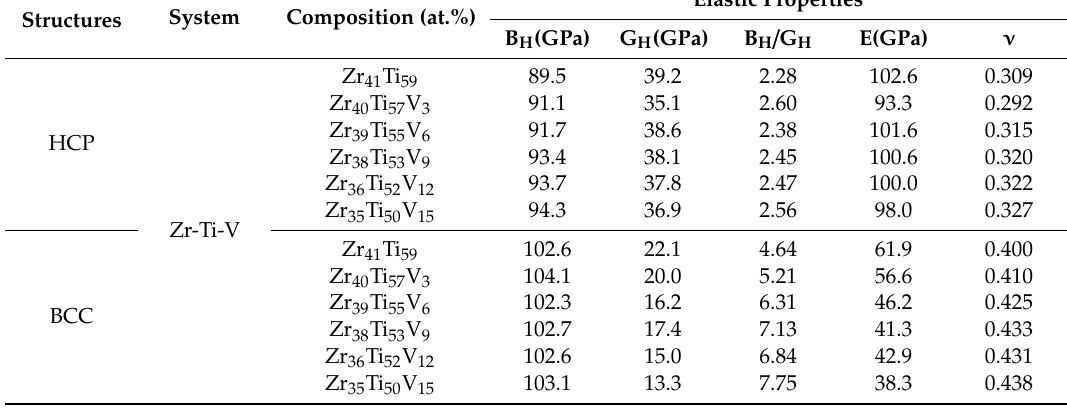
Table 10. Elastic properties of HCP structure and BCC structure Zr-Ti-V alloy systems. Structures System Composition (at.%)